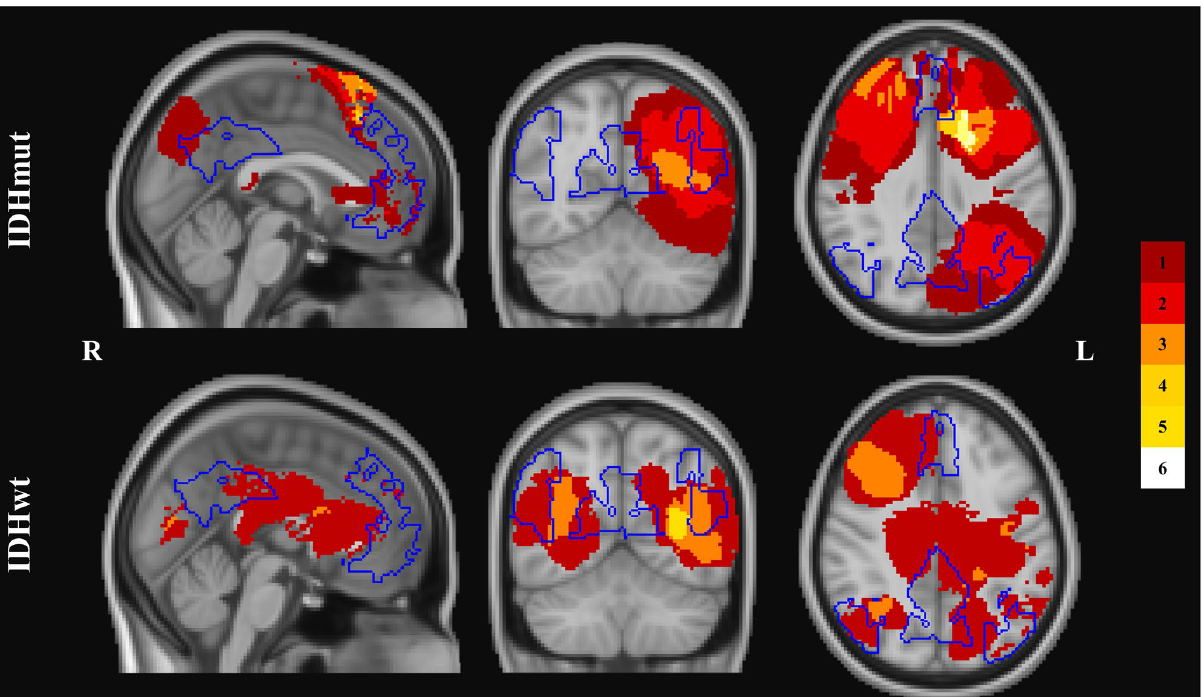
Figure 3. Overlap between Default-Mode Network regions and tumor locations. The distribution of right- and left- hemispheric tumor locations are displayed for isodehydrogenase-mutated (IDHmut) and wildtype (IDHwt) tumor patients. Regions with highest overlap in tumor occurrences are visualized in light yellow. Regions of the Default-Mode Network are overlaid in blue in order to visualize the overlap of patients’ tumor distribution and network